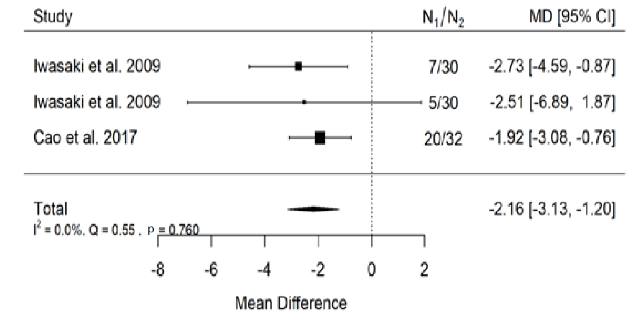
Figure 8. Forest plot of ANB values for the comparison of patients with untreated submucous cleft